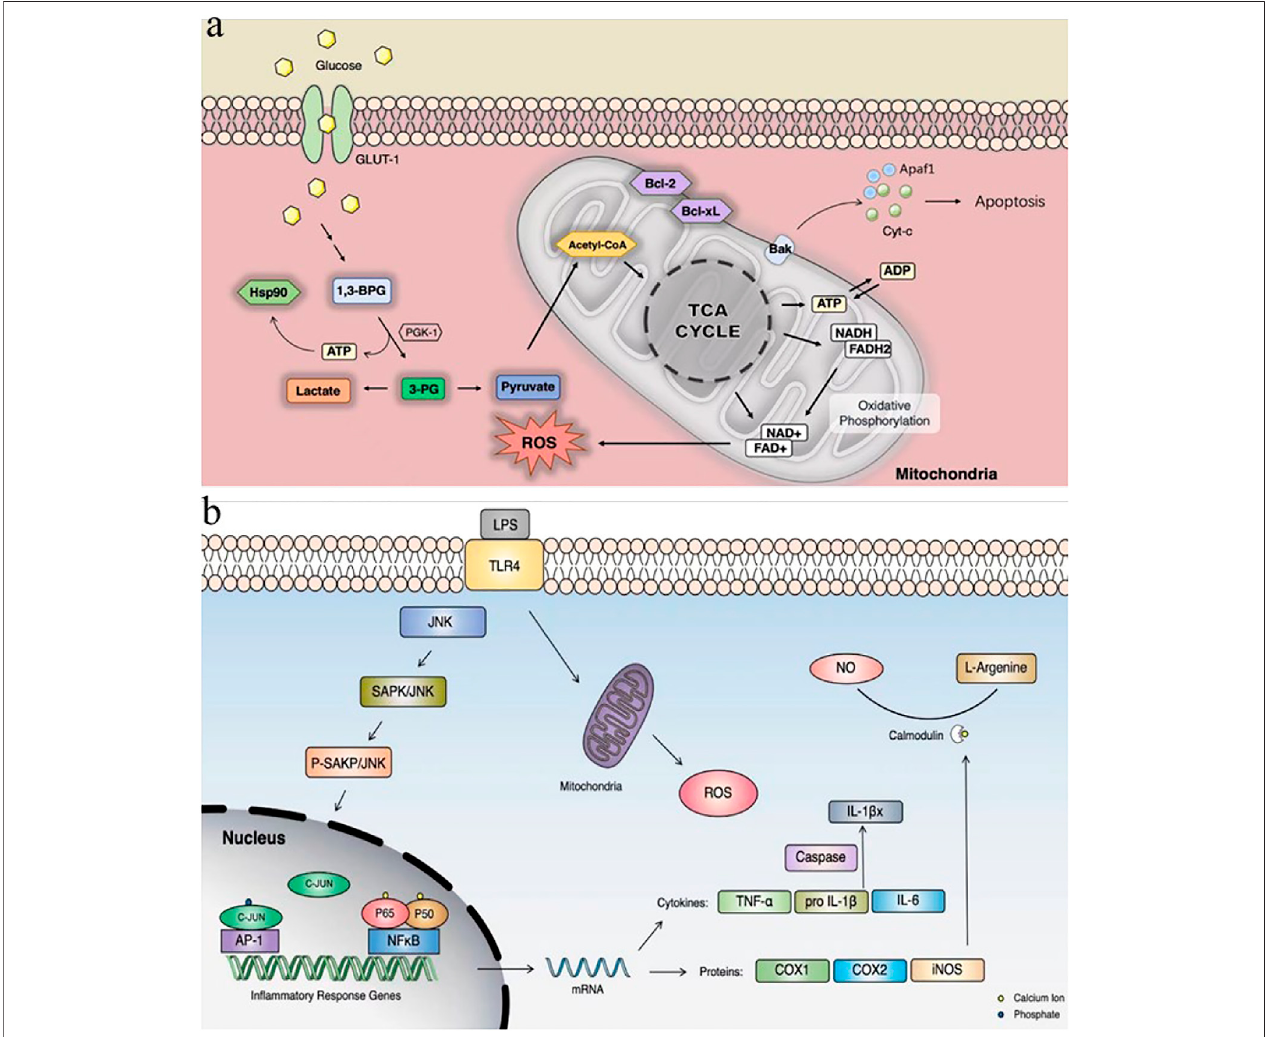
FIGURE 11 | (A) PGK1 glycolysis and inhibition of apoptotic pathways; (B) LPS-induced cellular in fl ammatory pathways. GLUT-1: glucose transport; Cyt C: cytochrome c; Apaf-1: apoptotic protease-1.